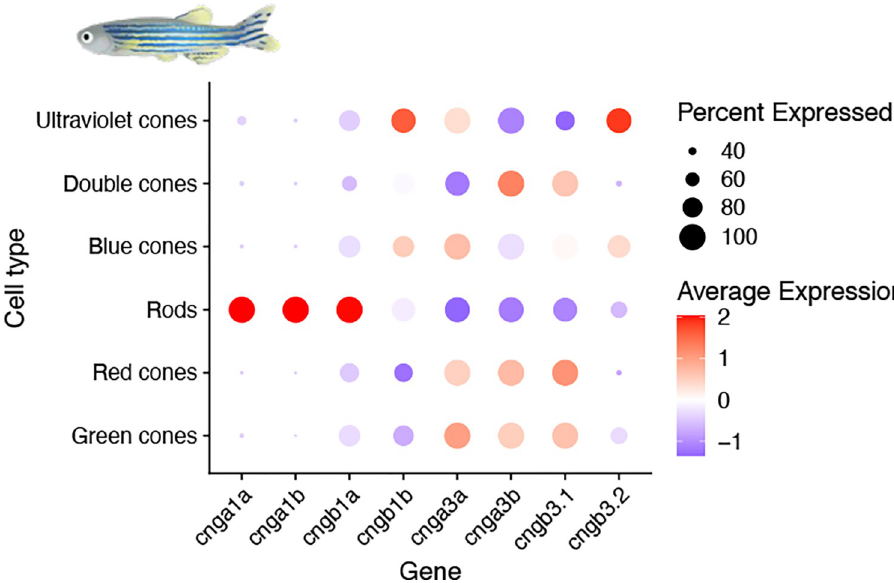
Fig 10. CNG gene expression data from zebrafish. Dot plot of the expression of zebrafish visual CNG genes in photoreceptor cell types in the retina. This data show that further specialization has occurred after the teleost-specific 3R event. Illustration of zebrafish was kindly provided by Dr. Daniel Ocampo